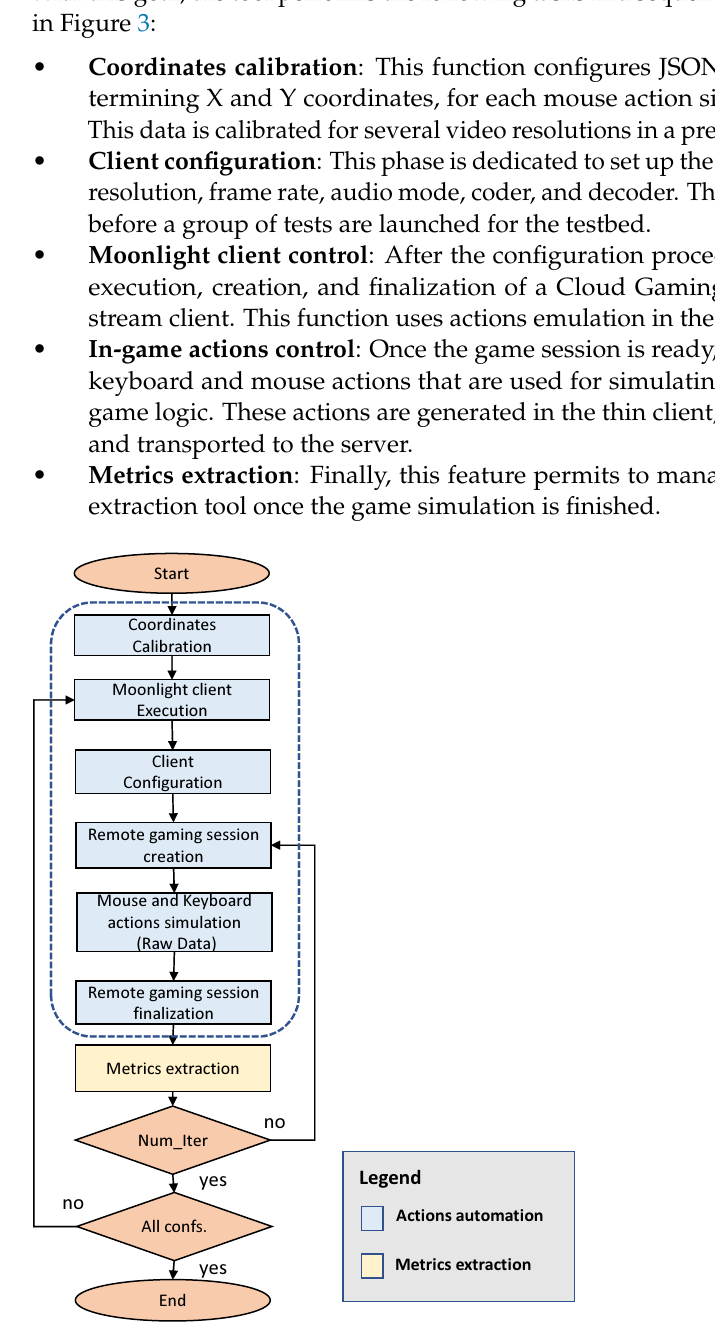
Figure 3. Software tool